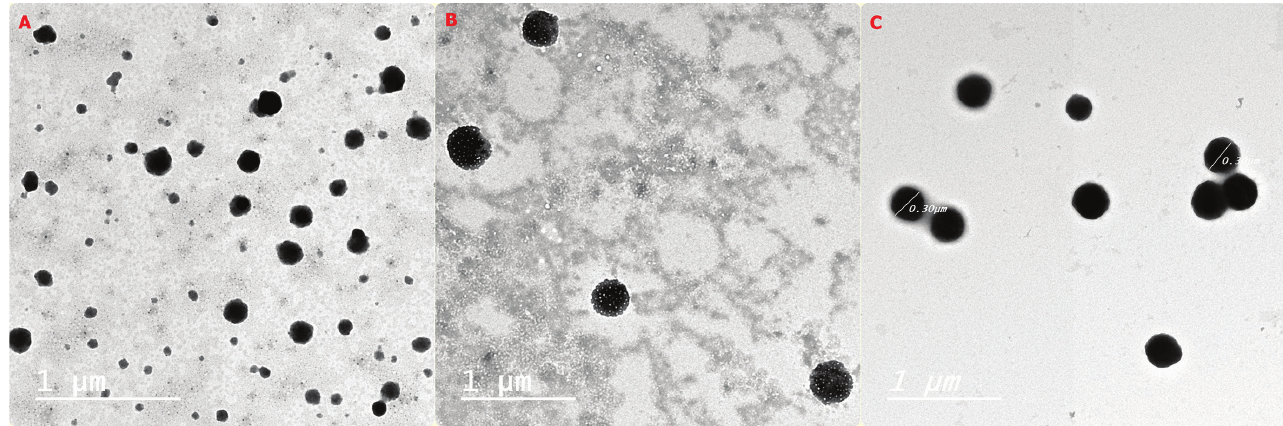
FIGURE 3 - Transmission electron microscope (TEM) images of A) Blank noisome; B) A. squamosa extract-entrapped noisome and C) A. squamosa extract-entrapped